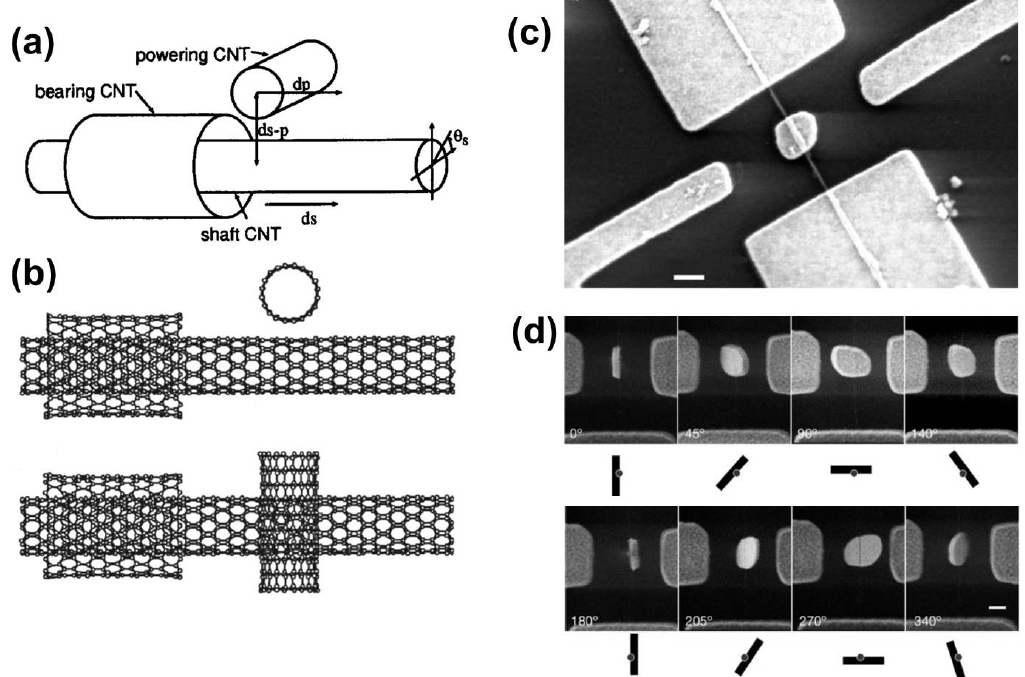
Figure 13. ( a ) The design of a nanomotor fabricated with one DWNT and one SWNT, which are mechanically coupled to each other. Reproduced with permission from [176], Copyright AIP Publishing LLC, 2008. ( b ) The side and top views of the nanomotor, respectively. Reproduced with permission from [176], Copyright AIP Publishing LLC, 2008. ( c ) SEM image of a nanomotor fabricated with a plate attached to the outer SWNT constituting a DWNT. Reproduced with permission from [177], Copyright Nature Publishing Group, 2003. ( d ) The plate at various angular positions (from 0–340 ◦ ). Reproduced with permission from [177], Copyright Nature Publishing Group,